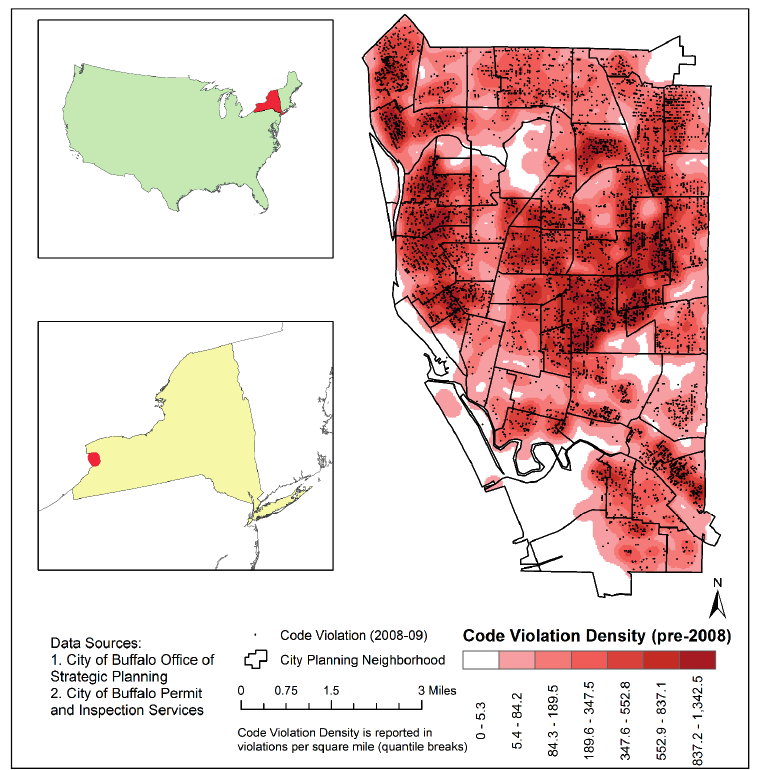
Figure 2. Distribution of violations in the study